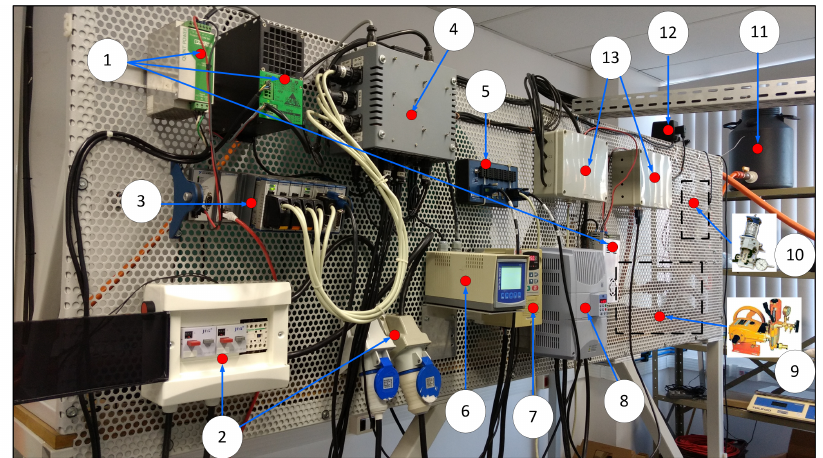
Figure 3. Front view of the agricultural sprayer development system (ASDS) electro-hydraulic devices: (1) power supplies, (2) electrical protection circuits, (3) modules for automation and control of input and output variables, (4) box with electronic circuits for signal conditioning, (5) CAN network bus, (6) transmitter for analog sensors, (7) frequency inverter for control of the spray pump, (8) frequency inverter for the control of industrial belt that simulates tractor movement in relation to sprayers, (9) spray pump, (10) two piston pumps for the injection of pesticides, (11) pesticide reservoir tank, (12) proportional valves for pressure and flow control, and (13) valve actuation circuits operated via CAN